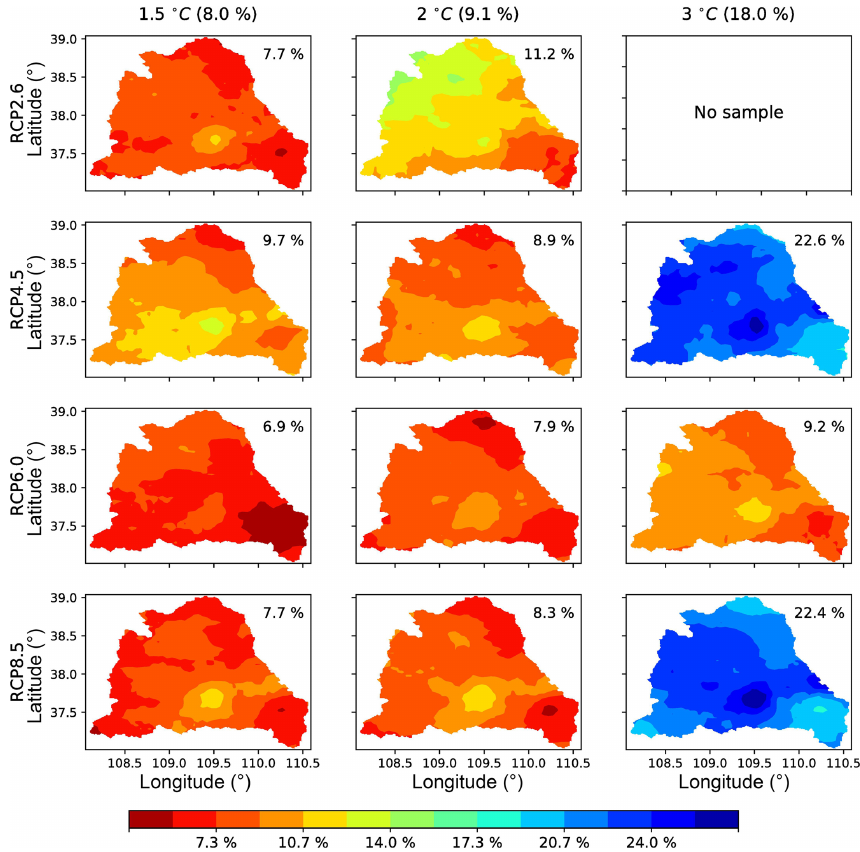
Figure 4. Spatial pattern of relative changes in multi-model ensemble mean precipitation at 1.5, 2 and 3 ◦ C warming levels compared to the baseline period (1986–2005). The percentages in the upper-right corners of each panel are the watershed-mean changes for different RCP scenarios, and the percentages in the top brackets are the mean values of all four RCP